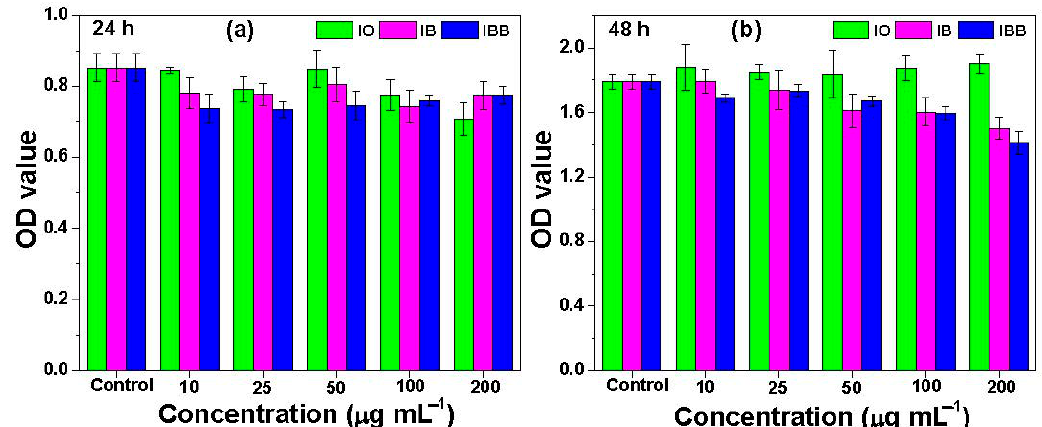
Figure 6. WST assay determination of the viability of HCT-15 colon cancer cells in the presence of various concentrations of IO, IB, and BSA-immobilized IB (IBB) nanocomposites for ( a ) 24 h or ( b ) 48 h. The error bars represent the standard deviation ( p < 0.05).